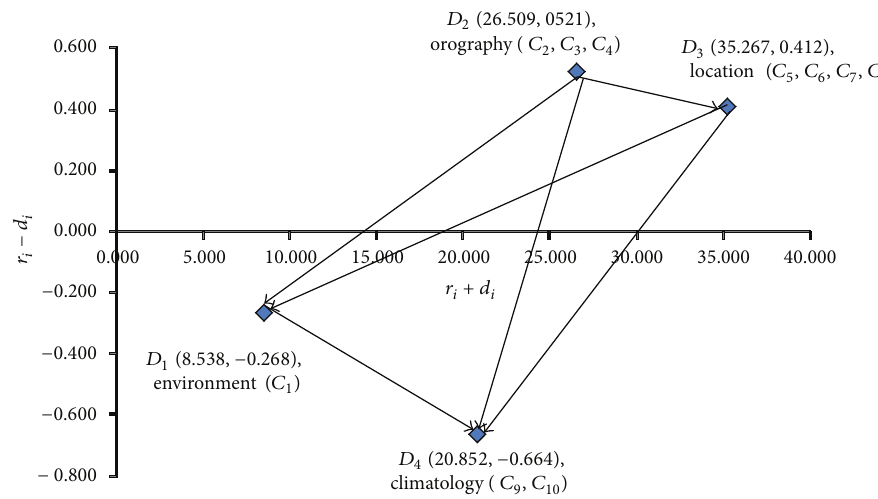
Figure 2: The INRM of influential relationships within solar